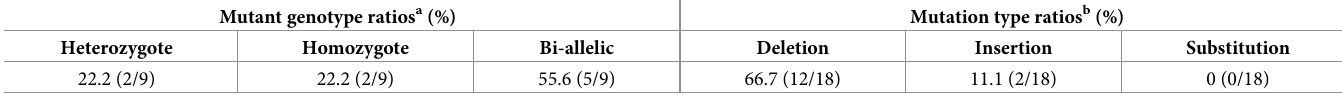
a (Number of on-target mutant genotype/total number of on-target mutant genotypes) x 100%. b (Number of allele mutation type/number of all allele mutation types) x 100%.